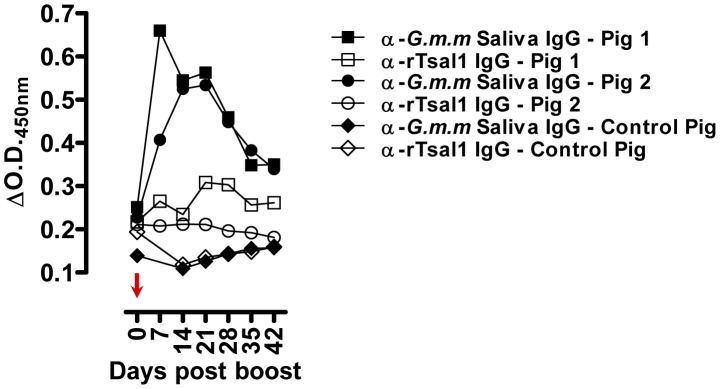
Effect of boosting in pigs after a period of non-exposure.Evolution of the anti-G. m. morsitans saliva IgG responses and the anti-rTsal1 IgG repsonses was evaluated in pigs (n = 2) originally exposed two-weekly for 6 weeks to the bites of 3 flies ( = low exposure group) and re-exposed to the bites of 10 flies (indicated by an arrow) after a 2-month period of non-exposure. One non-exposed animal sampled during the priming experiment (Figure 5) served as a negative control. Presented data are mean ΔO.D.450 nm values with the 95% CI obtained with a 1∶1600 dilution of the individual plasmas.